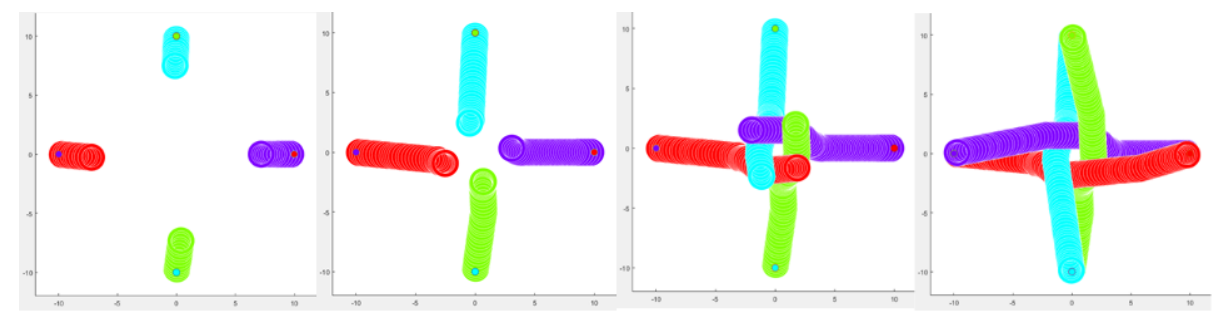
Figure 15. Path generation of the four robots, considering the evolution of the performance of the ORCA algorithm in a dynamic simulation environment without human presence.